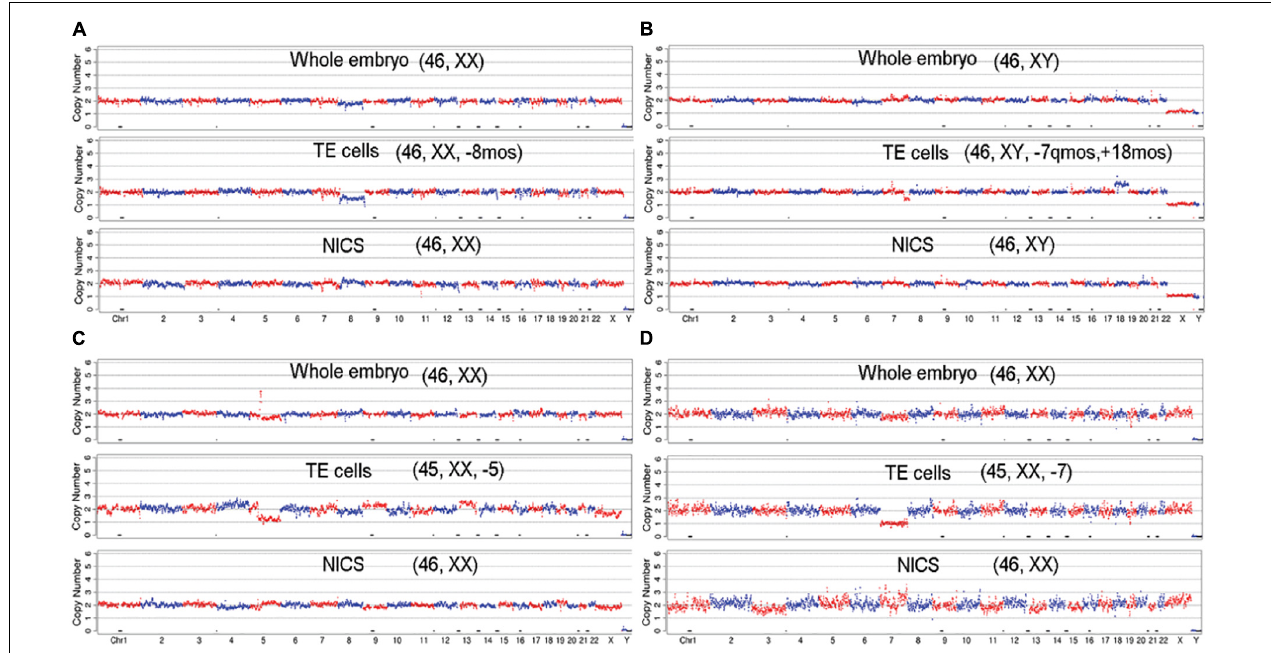
FIGURE 5 | The CNV profiles of mosaic embryos with aneuploid/mosaic aneuploid TE biopsies, but with euploidy in whole embryo and NICS. The embryos show normal karyotype in whole embryo and NICS, but TE cells indicate mosaic profiles: (A) [46, XX, –8mos]; (B) [46, XY, –7q(q31.33 → qter, ∼ 30M) mos, +18mos]; or aneuploid profiles: (C) [45, XX, –5]; (D) [45, XX,